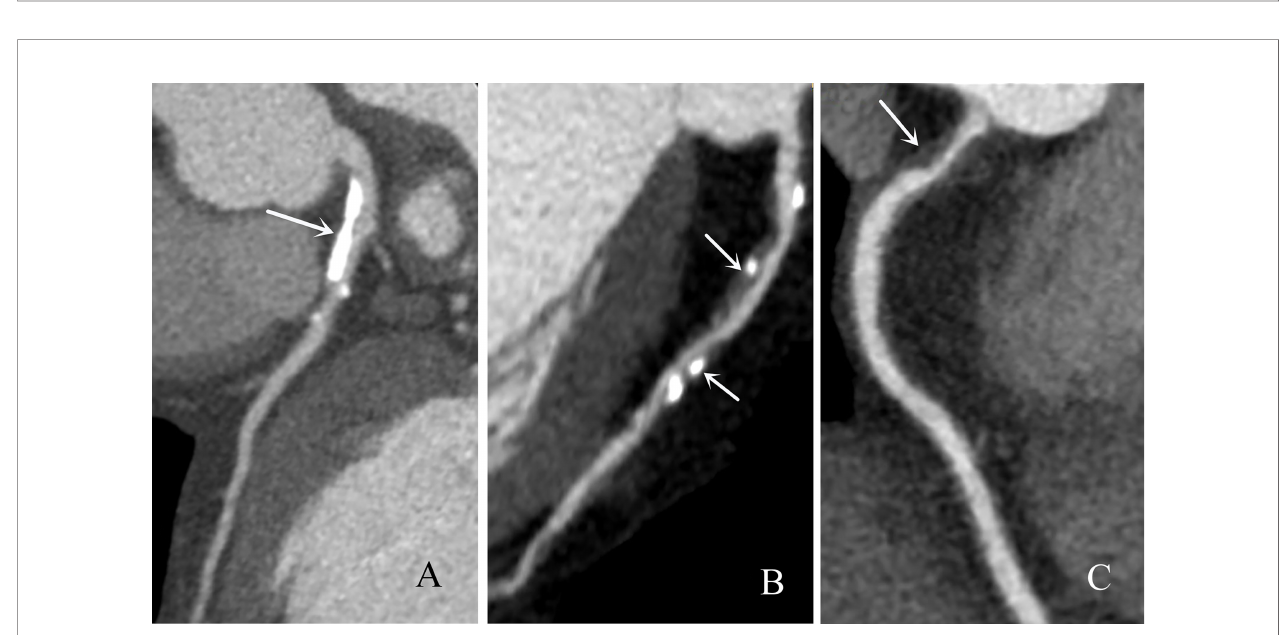
FIGURE 2 | Representative CCTA images of types of coronary artery plaques. (A) Calci fi ed plaques (arrow), (B) mixed plaque (arrow) and (C) noncalci fi ed plaque